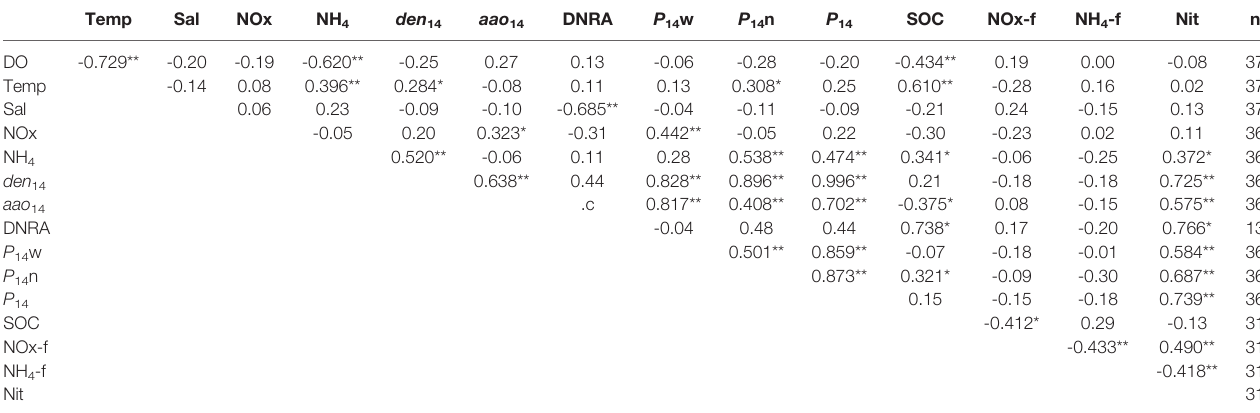
TABLE 3 | Pearson ’ s correlation analyses coef fi cients for ambient bottom water conditions, nutrient fl uxes, and nitrogen transformation rates from intact core incubation using Jinhae Bay sediments. Temp